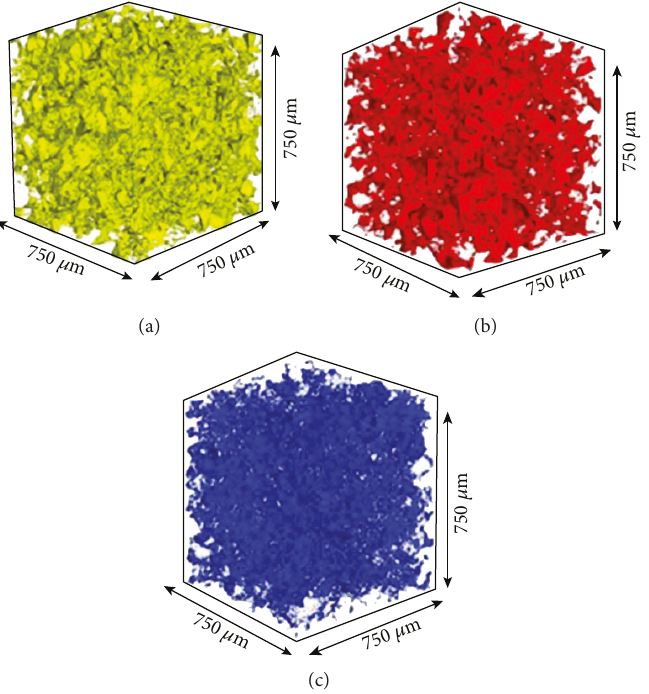
Figure 5: 3D reconstruction results. Note: (a) distribution of the pore-throat system in the core sample; (b) distribution of irreducible water; (c) distribution of simulated oil. Table 1: Segmentation result of the core sample containing irreducible